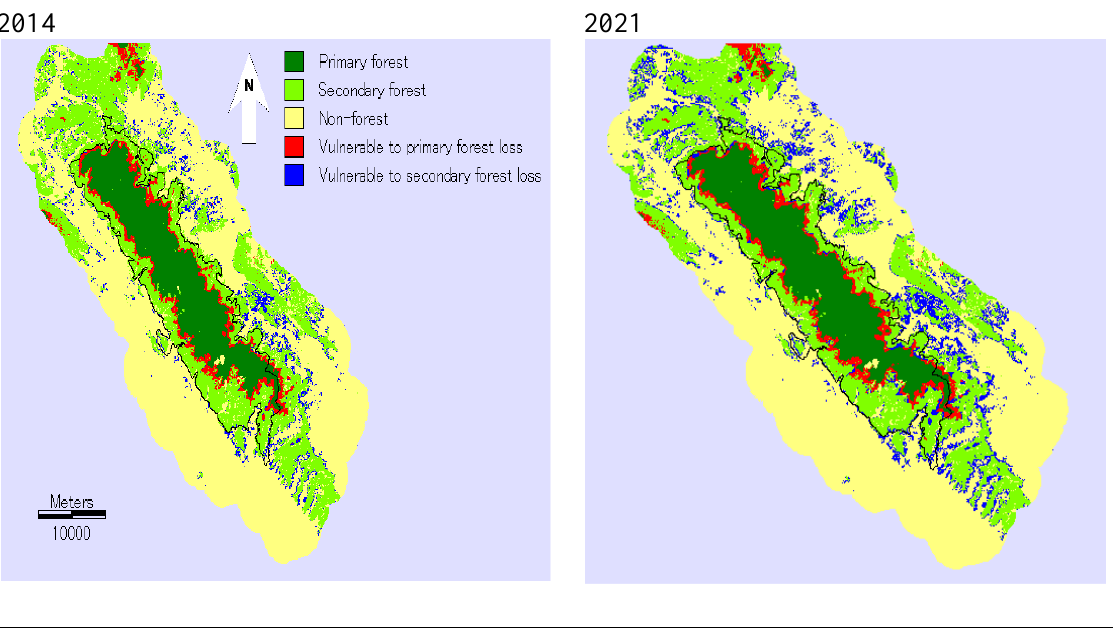
Table 6. Forest cover for 1993–2007 and predicted forest cover in 2014 and 2021